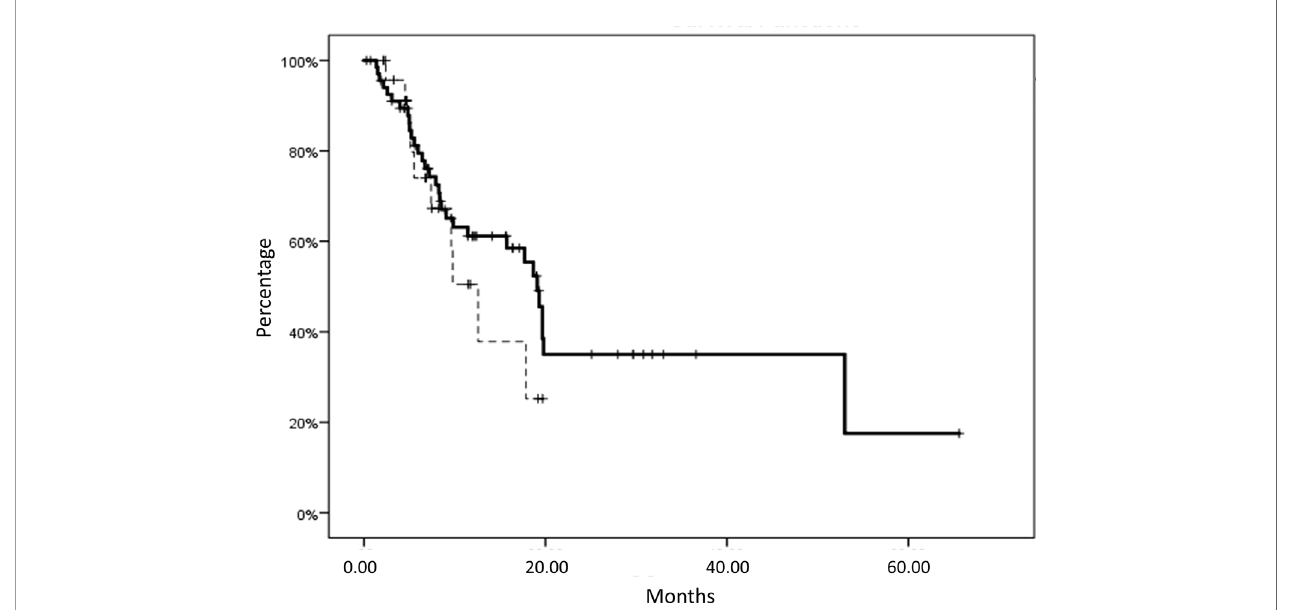
FIGURE 1 | Overall survival (OS) of patients with metastatic non-small cell lung cancer (mNSCLC) subjected to nivolumab (solid line) or atezolizumab treatment (dashed line). No statistical differences in survival were correlated with the treatment (nivolumab vs . atezolizumab, p:0.378). Nivolumab subgroup median OS: 19 ± 0.8 months, mean OS: 27.9 ± 3.9 months, versus Atezolizumab subgroup median OS: 12.5 ± 2.1 months, mean OS: 12.1 ± 1.6